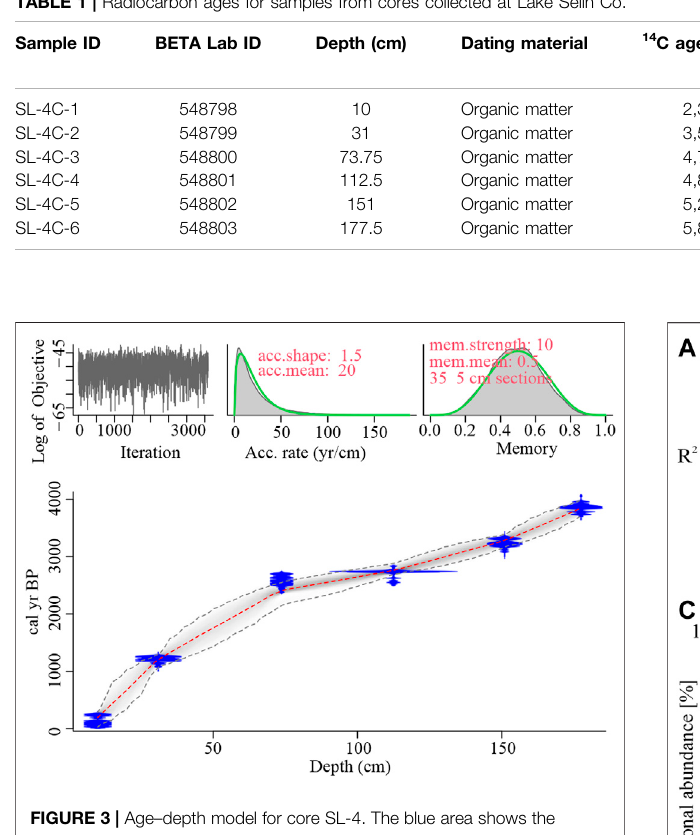
TABLE 1 | Radiocarbon ages for samples from cores collected at Lake Selin Co.